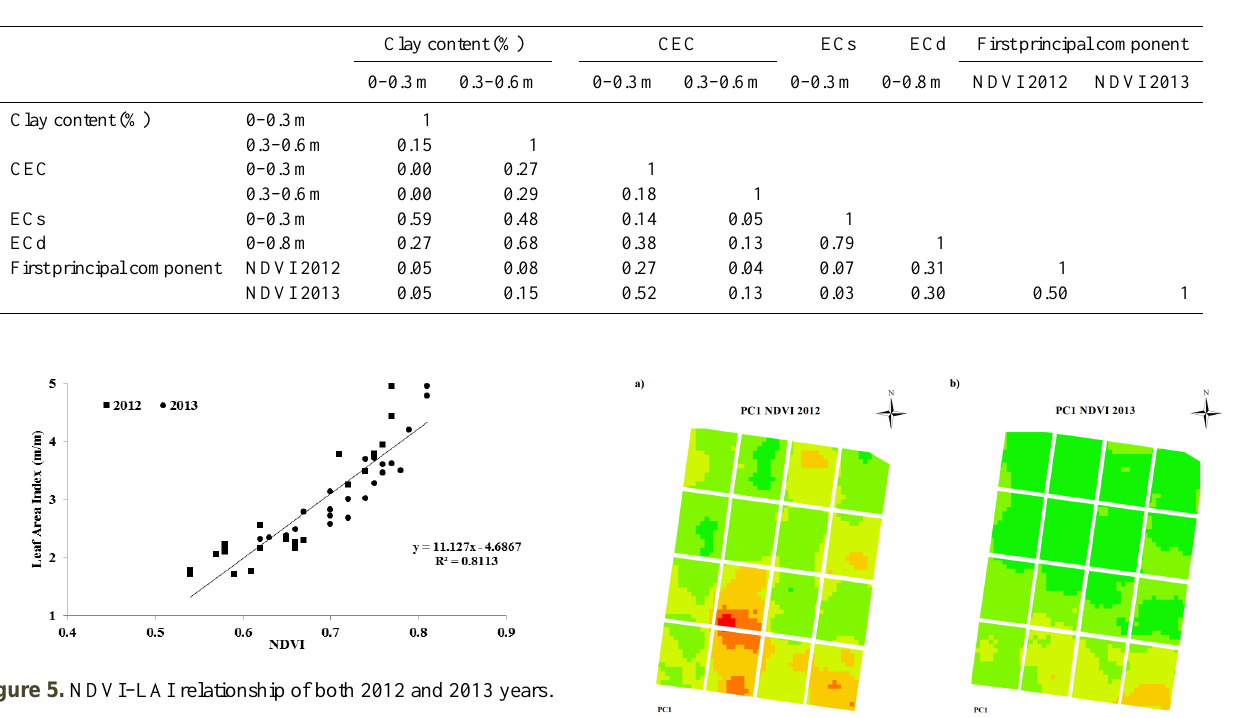
Table 4. Correlation matrix ( R 2 ) among properties and vegetative vigour expression of the vineyard assay area.